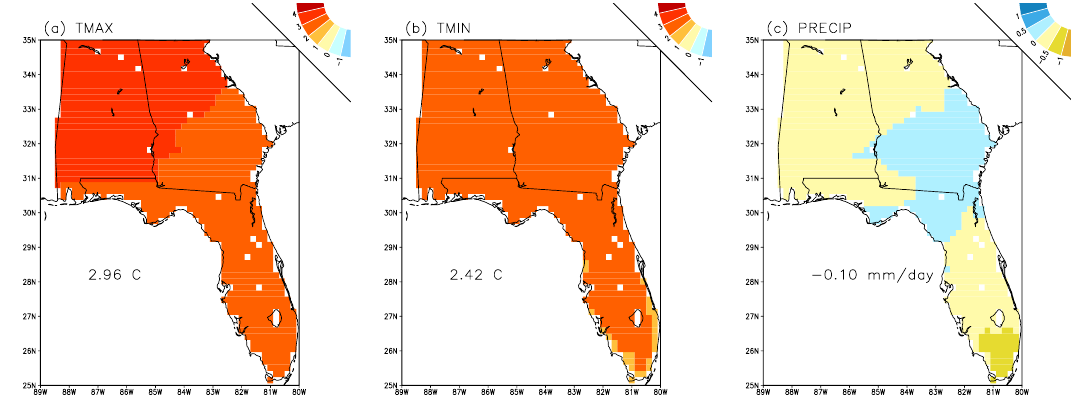
Figure 2. Projected ( a ) maximum temperature, ( b ) minimum temperature, and ( c ) precipitation differences between future (year 2041–2070) and current (year 1971–2000) NARCCAP runs. All ten employed models are simply averaged. Area averaged values are shown. Table 3. Projected area-average maximum temperature, minimum temperature, and rainfall differences between future (2041–2070) and current (1971–2000) NARCCAP runs.